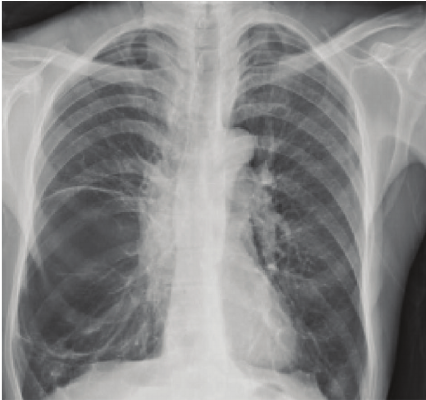
Figure 3: Posttreatment chest X-ray.